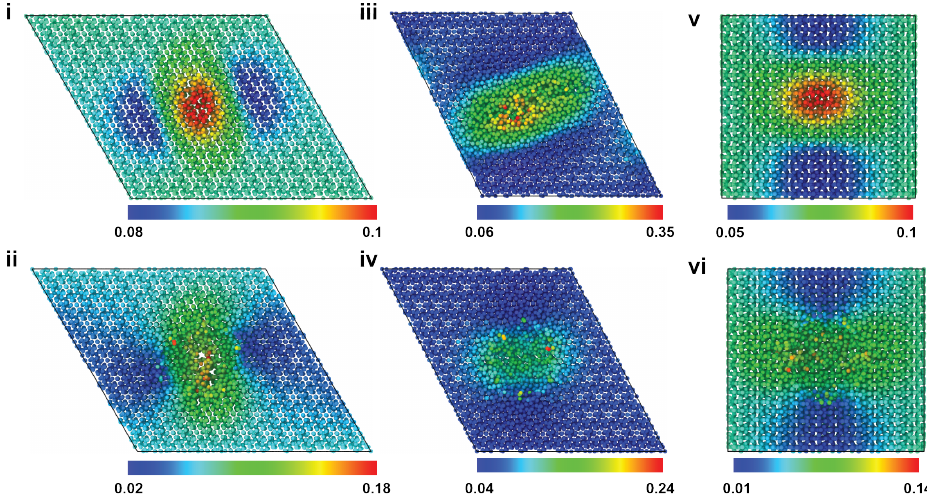
Figure 2. Atomic snapshots of HAP models at the inception of tensile failure for 7.5 Å (top row) and 30 Å (bottom row) pores, for X ( i , ii ), Y ( iii , iv ), and Z ( v , vi ) loading. Atoms are colored according to the von Mises strain. X and Y loading images are viewed in the X-Y plane, whereas the Z loading image is in the Y-Z plane.